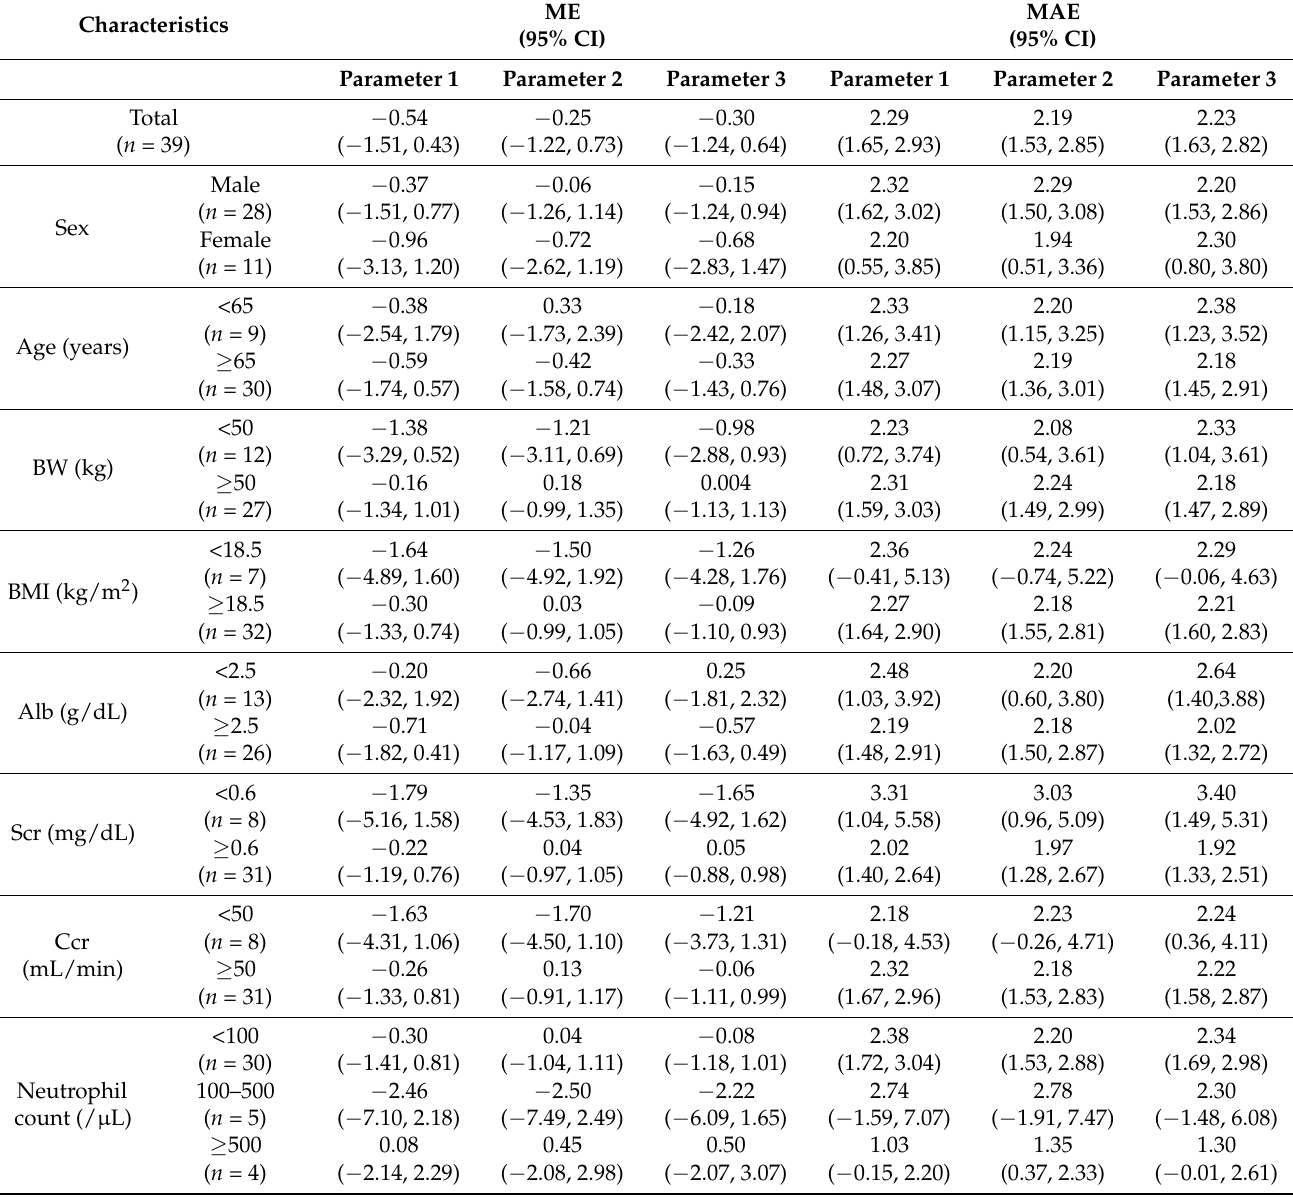
Table 3. Comparison of prediction accuracy by patient